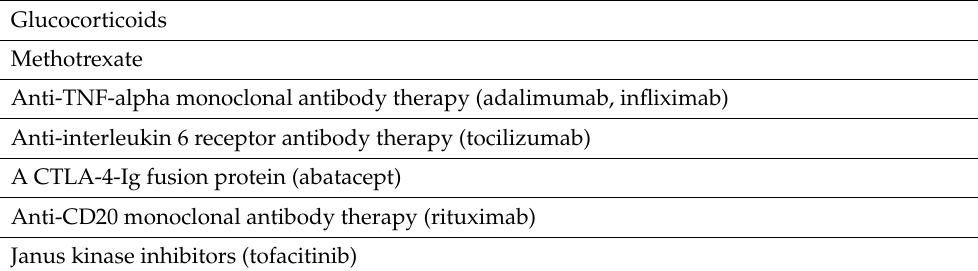
Table 2. Medical options in pediatric